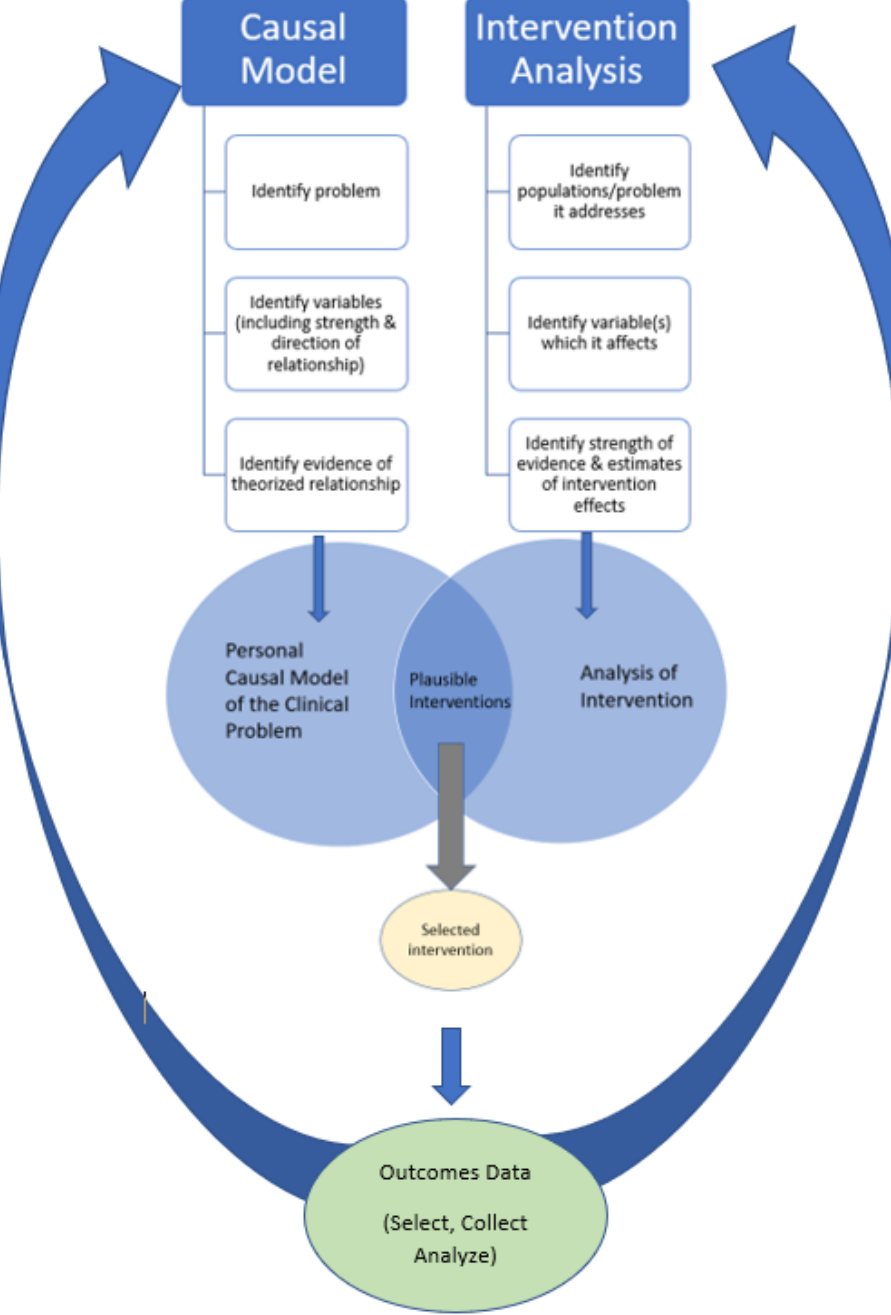
Figure 1. Simple view of intervention selection (diagram only contains the main steps of each